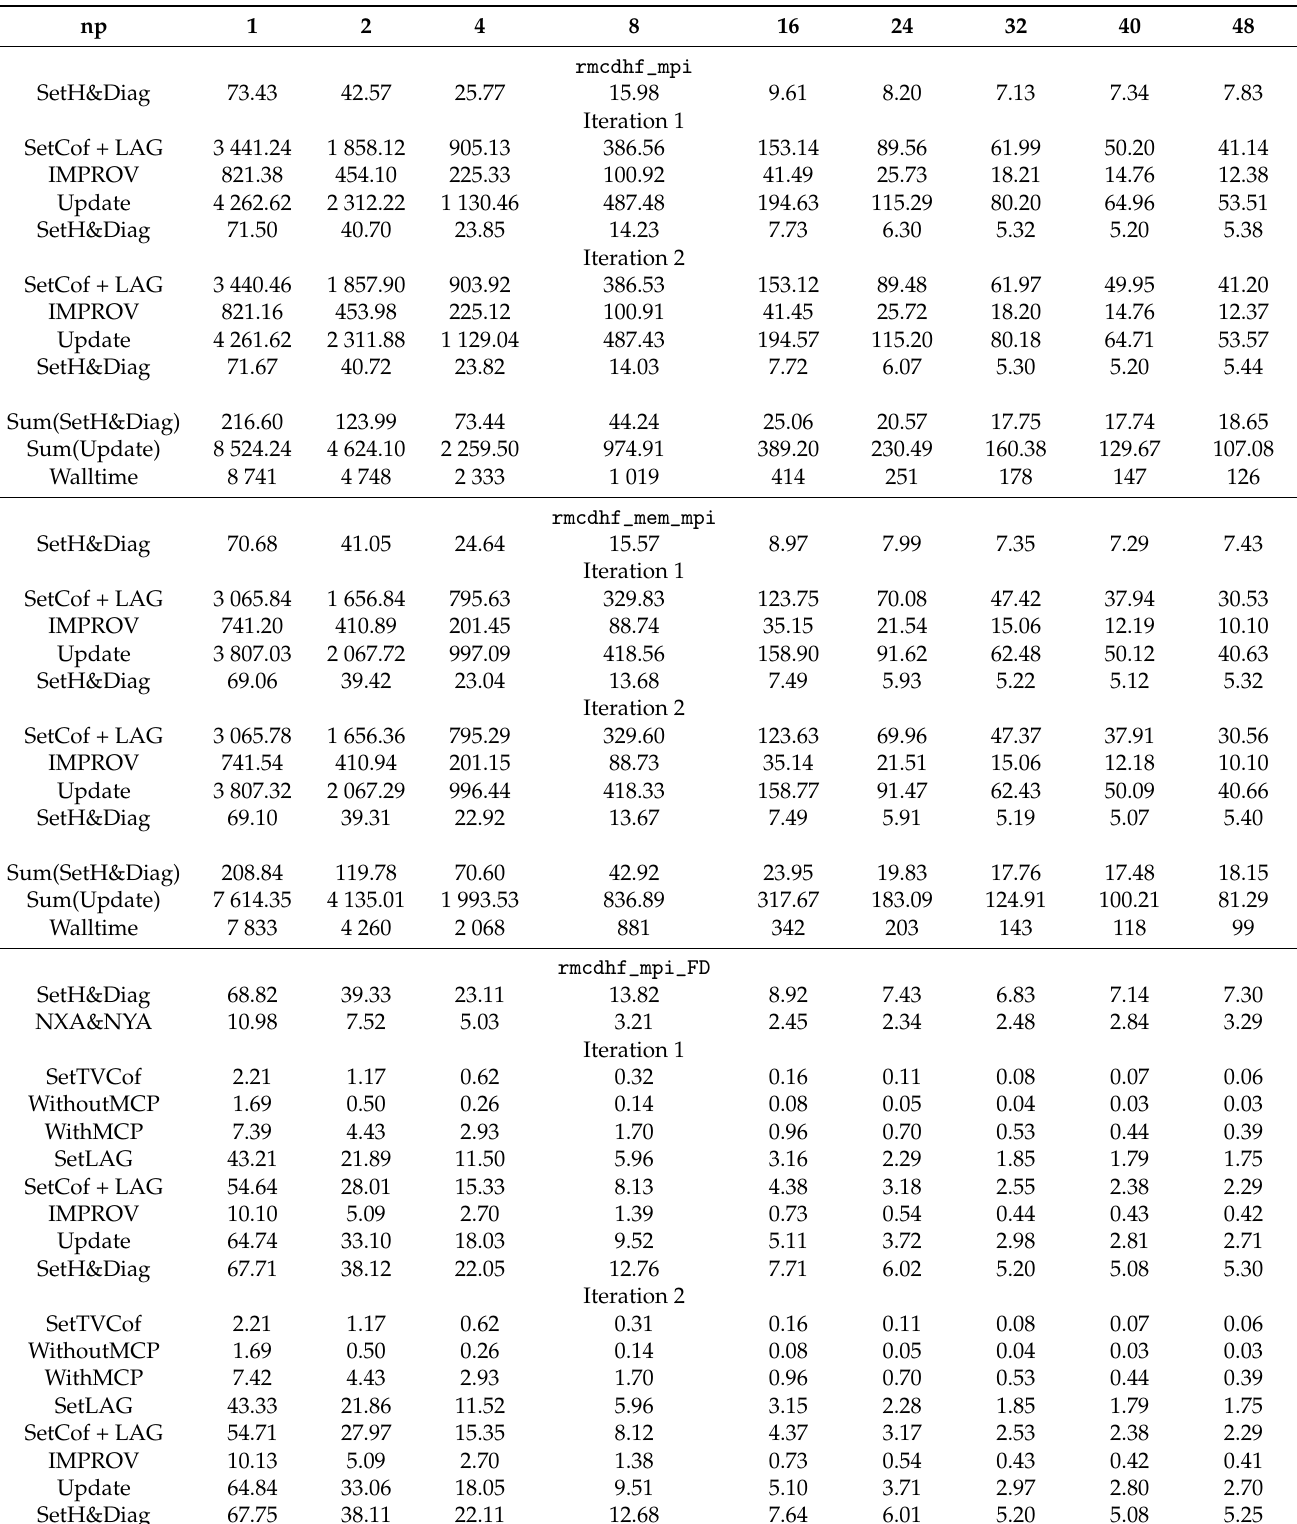
Table 4. CPU times (in s) for the Be I n = 9 SCF calculations using the rmcdhf_mpi , rmcdhf_mem_mpi and rmcdhf_mpi_FD codes as a function of the number of MPI processes ( np ). See text for